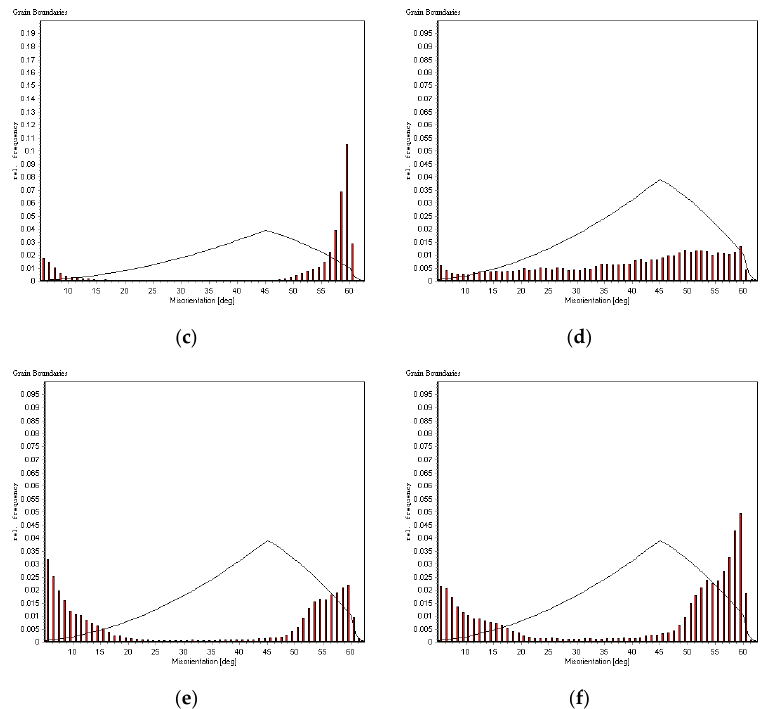
Figure 13. Frequency of HAGBs and LAGBs in the welding thermal simulation samples: ( a ) CGHAZ of 0 V; ( b ) CGHAZ of 10 V; ( c ) GRHAZ of 0 V; ( d ) GRHAZ of 10 V; ( e ) ICHAZ of 0 V; and ( f ) ICHAZ of 10 V. The precipitation features in the welding thermal simulation samples of the 10 V steel were analyzed by TEM, and the distribution and elemental analysis of the precipi- tates are shown in Figure 14. In the simulated CGHAZ, almost no precipitates were ob- served; in the simulated GRHAZ, a small amount of precipitates with a small size were observed at the grain boundaries; and in the simulated ICHAZ, the micro-sized precipi- tates were found at the selected region.